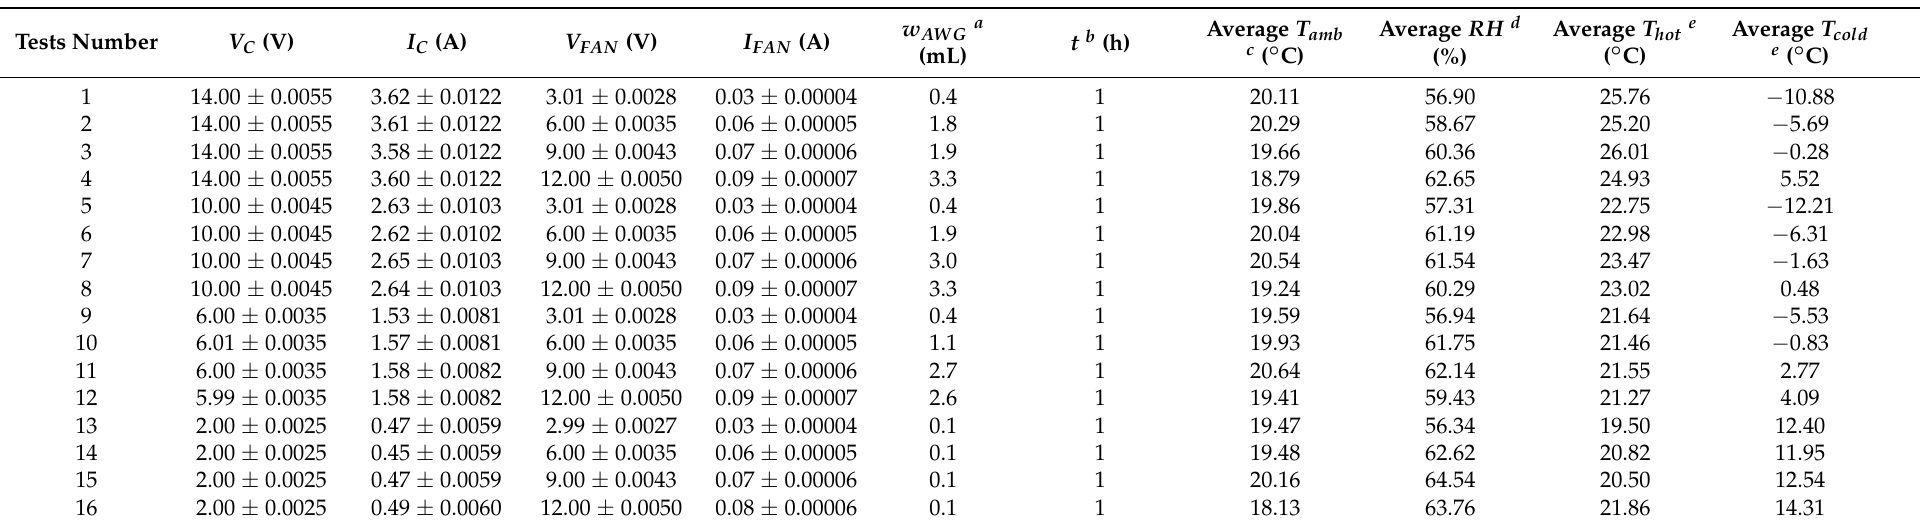
Table 2. Measured variables’ results for the parametric